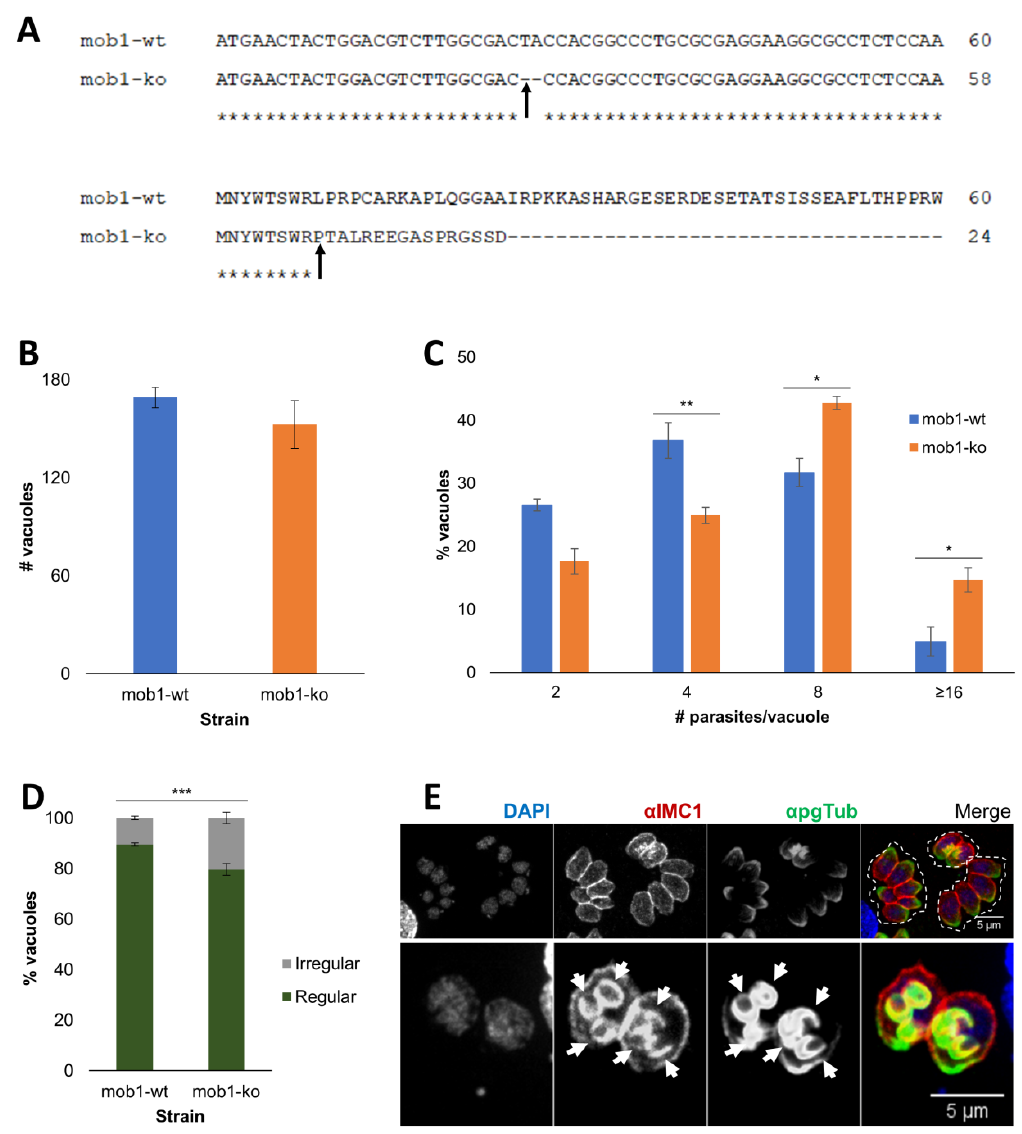
Figure 4. Mob1 knockout causes a slight increase in tachyzoite replication rates and irregular parasitophorous vacuole occurrence. ( A ) Comparison of sgRNA1 mob1 -wt and mob1 -ko strain DNA and predicted protein sequence. The mob1 -ko predicted protein sequence is truncated by a premature STOP codon. Asterisks signal conserved regions and the arrows indicate the place of sequence disruption. At the bottom of the alignment, asterisks (*) signal invariant residues. ( B ) Invasion assays did not detect significant differences between mob1 -wt and mob1 -ko tachyzoites ( p = 0.3241). ( C ) Replication assays detected significant differences between mob1 -wt and mob1 -ko tachyzoites ( p < 0.0001). Mob1 -ko tachyzoites present a higher replication rate compared to mob1 -wt tachyzoites. *— p < 0.05; **— p < 0.01. ( D ) PV regularity assays detected significantly higher irregular vacuoles in mob1 -ko tachyzoites compared to mob1 -wt tachyzoites ( p = 0.004). ***— p < 0.001. ( E ) Immunofluorescence of mob1 -ko tachyzoites showing regular (two and four tachyzoites) and irregular (six tachyzoites) vacuoles ( top panel ). No defects were observed regarding cytoskeleton morphology. We observed vacuoles with three daughter cells forming inside each mother cell ( bottom panel , arrows). The inner membrane complex is stained with anti-IMC1 ( α IMC1), the tubulin cytoskeleton is stained with anti-polyglutamylated Tubulin ( α pgTub), and the nuclei are stained with DAPI. Data are presented as mean ± SE of three independent experiments. mob1 -wt, RHsCas9 expressing the mob1 sgRNA1; mob1 -ko, mob1 functional knockout expressing the mob1 sgRNA1; Irregular, vacuoles with numbers of tachyzoites different from 4, 8, 16, or 32; Regular, vacuoles with numbers of tachyzoites equal to 4, 8, 16, or